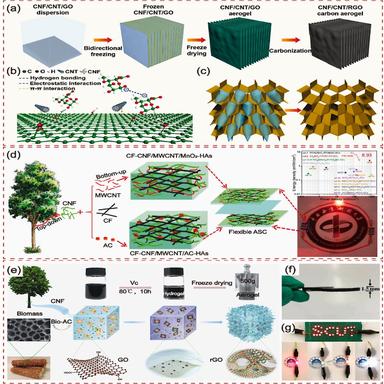
(a) Schematic representation of CNF/CNT/RGO fabrication process. (b) Illustration of the interaction between CNF, CNT, and RGO. (c) Schematic diagram of ice crystal growth mechanism. (d) Schematic illustration of the design of the CF-CNF/MWCNT/MnO2 and CF-CNF/ MWCNT/AC flexible electrodes, and the construction of flexible ASCs. (e) Graphical depiction of the self-assembly of the ternary bio-AC/RGO/CNF aerogel. (f) Digital image of the self-supporting hybrid aerogel electrode. (g) Demonstration of the LED li